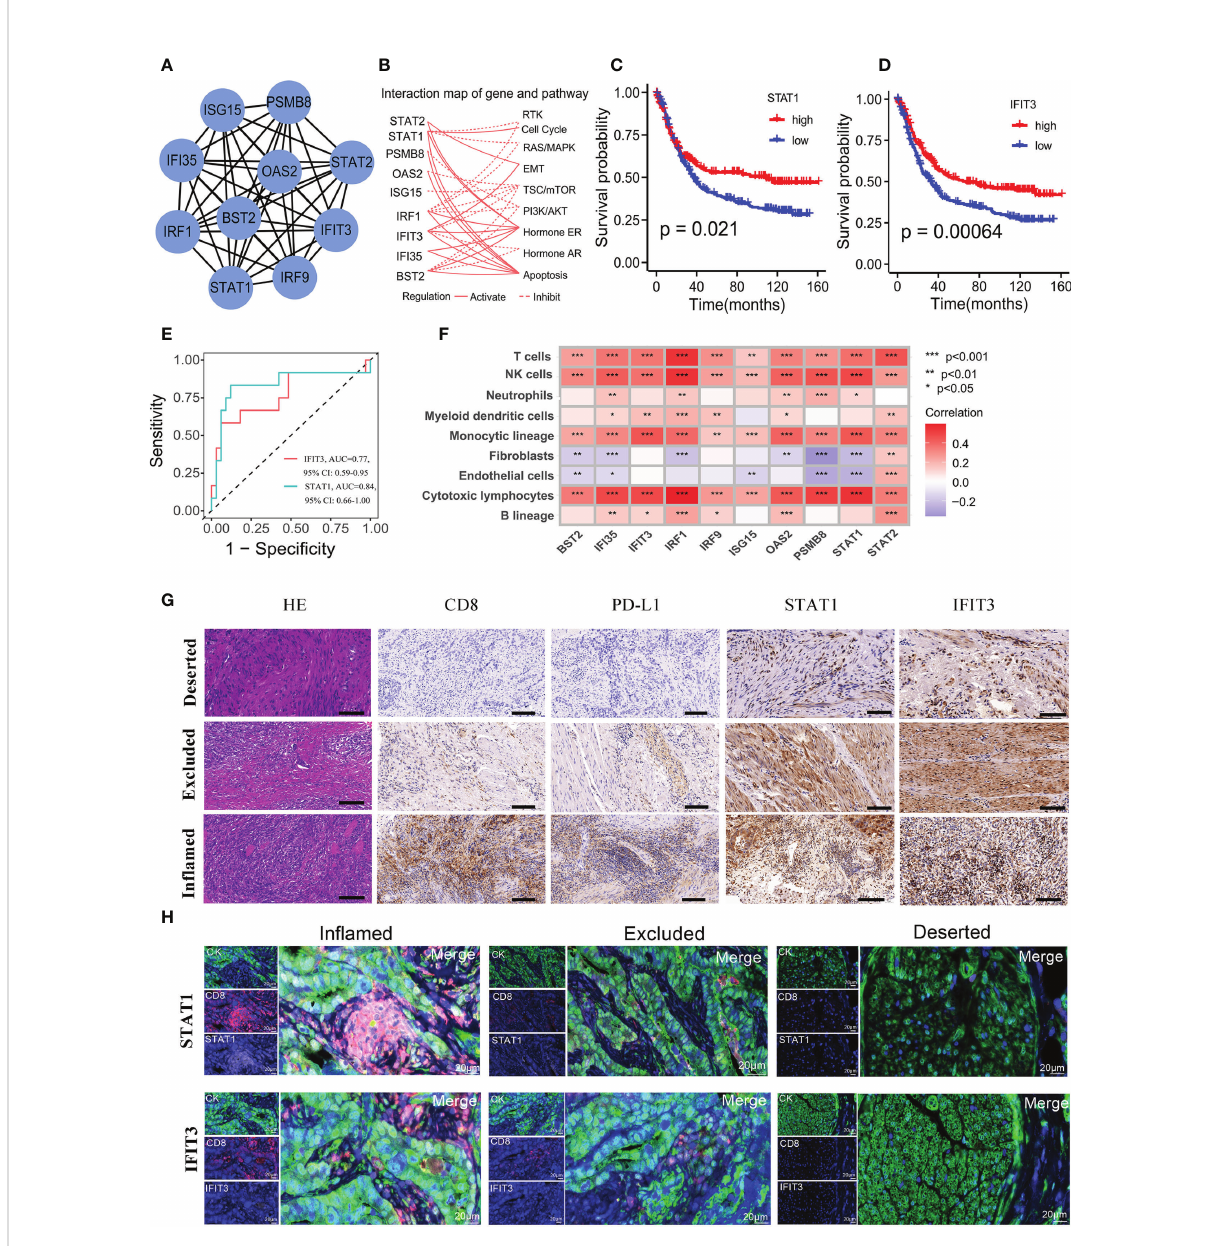
FIGURE 4 Selection and characteristics of hub genes associated with immunotherapy response and prognosis. (A) A network of protein-protein interactions for 10 hub genes. (B) The pro fi les of hub genes affecting canonical signaling pathways. The Kaplan-Meier survival curves of STAT1 (C) and IFIT3 (D) expression affecting prognosis. (E) ROC for the STAT1 and IFIT3 predicting immunotherapy response in the Kim cohort. (F) The correlations of hub genes with abundance of seven immune and two stromal cells, calculated by the MCP-counter method. (G) Immunohistochemistry detected the expression of CD8, PD-L1, STAT1, and IFIT3 in the immune-in fl amed subtype, immune-excluded subtype, and immune-deserted subtype of GC. The scale corresponds to 50 m m. (H) Multi-color fl uorescence staining detected the spatial distribution of STAT1, IFIT3 and CD8 in the immune-in fl amed subtype, immune-excluded subtype, and immune-deserted subtype of GC. The scale corresponds to 20 m